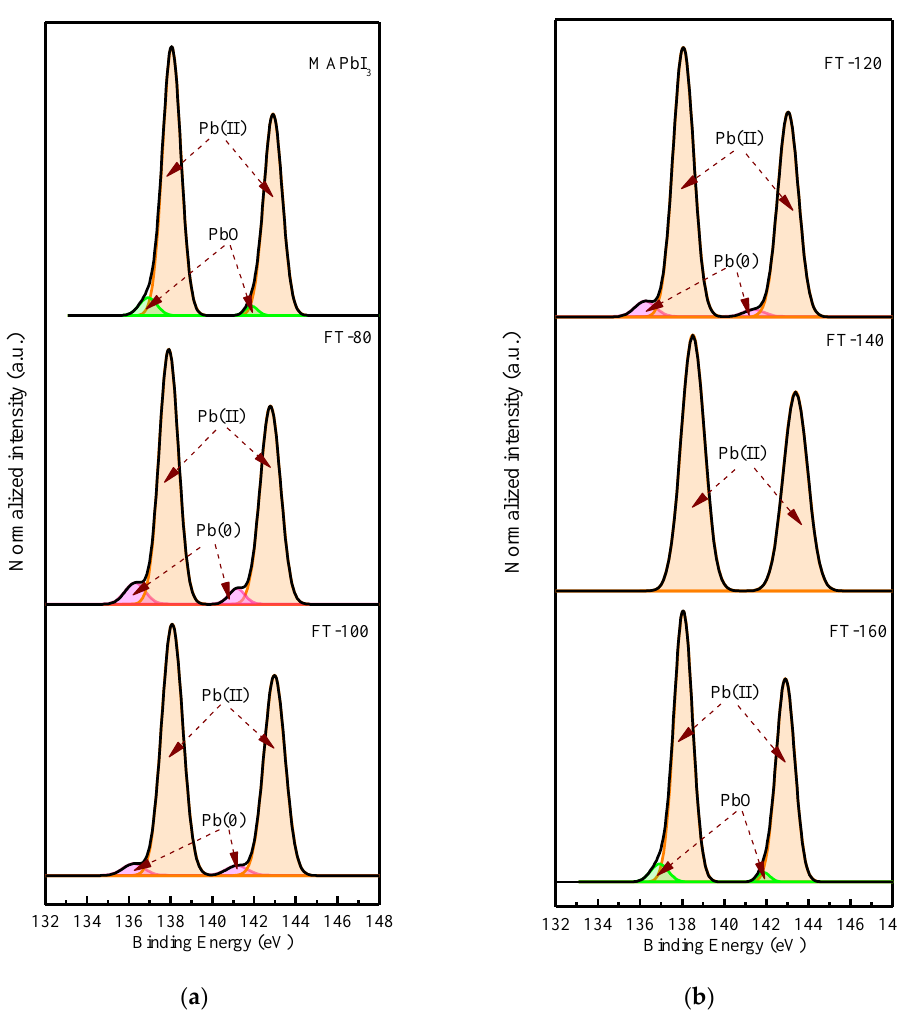
Figure 5. XPS core-level spectra of Pb 4f ( a ) Pristine MAPbI 3 and CsPbI 3 -QD doped MAPbI 3 under different filming temperatures (FTs) from 80 to 100 ◦ C. ( b ) CsPbI 3 -QD doped MAPbI 3 under different filming temperatures (FTs) from 120 to 160 ◦ C.